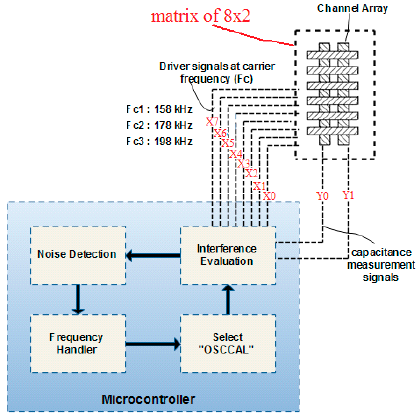
Figure B1. Frequency hopping approach based on capacitive sensors with interference rejection.